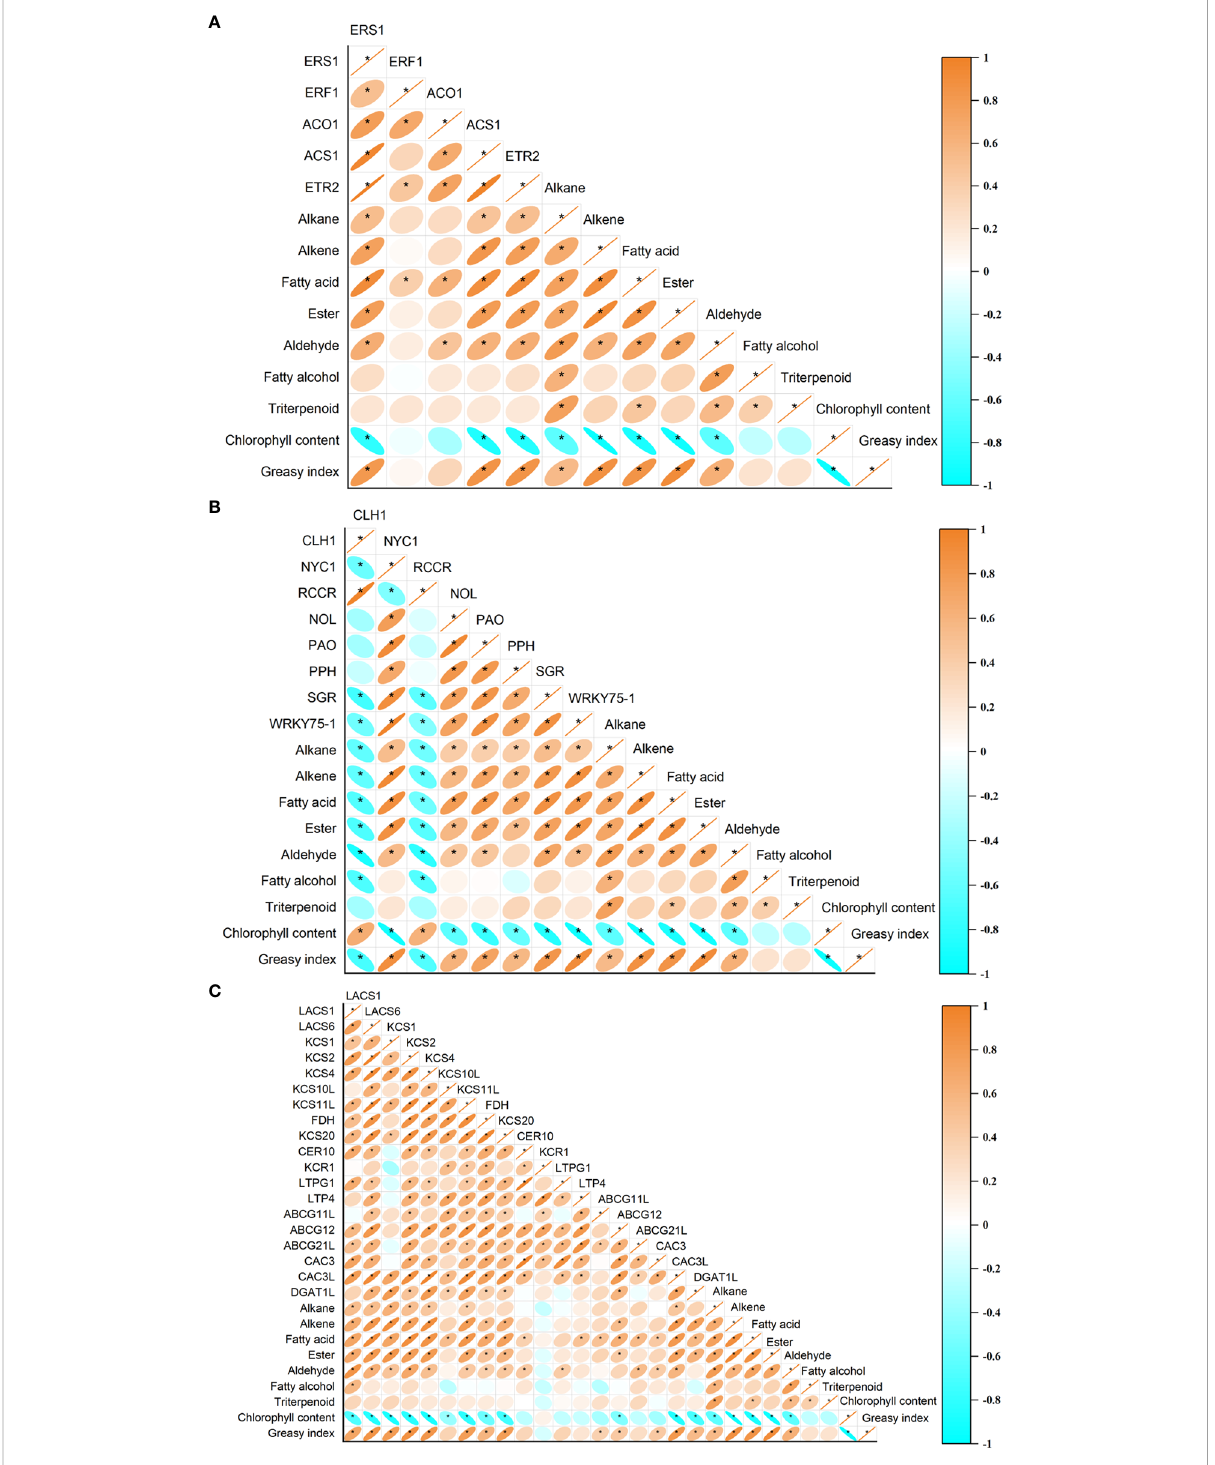
FIGURE 9 The relationships between peel greasiness index, chlorophyll content, and wax composition and (A) ethylene-related genes, (B) chlorophyll degradation genes, and (C) wax synthesis and transporter genes. The correlation signi fi cant level was set at